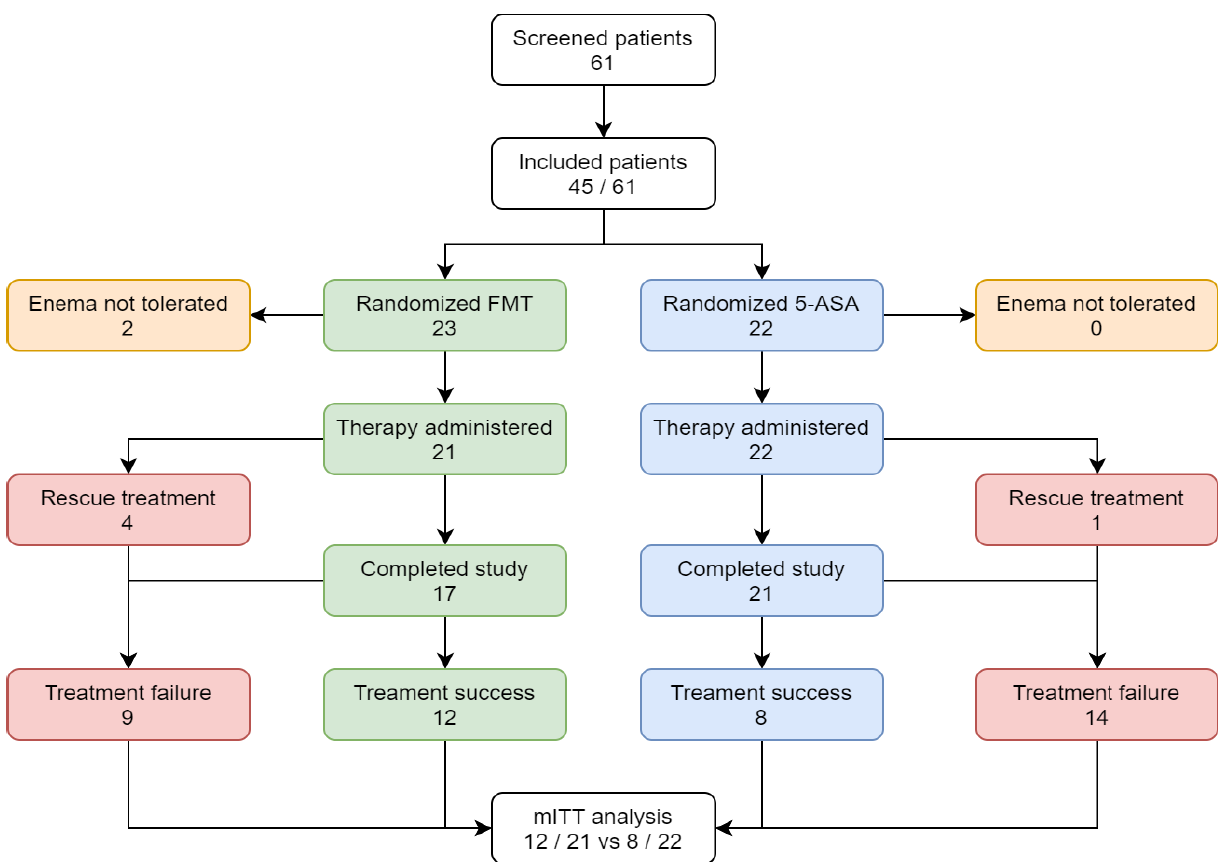
Figure 1. Trial profile. 5-ASA, 5-aminosalicylic acid; FMT, fecal microbial transplant; mITT, modified intention-to-treat. Table 1. Patient baseline characteristics.